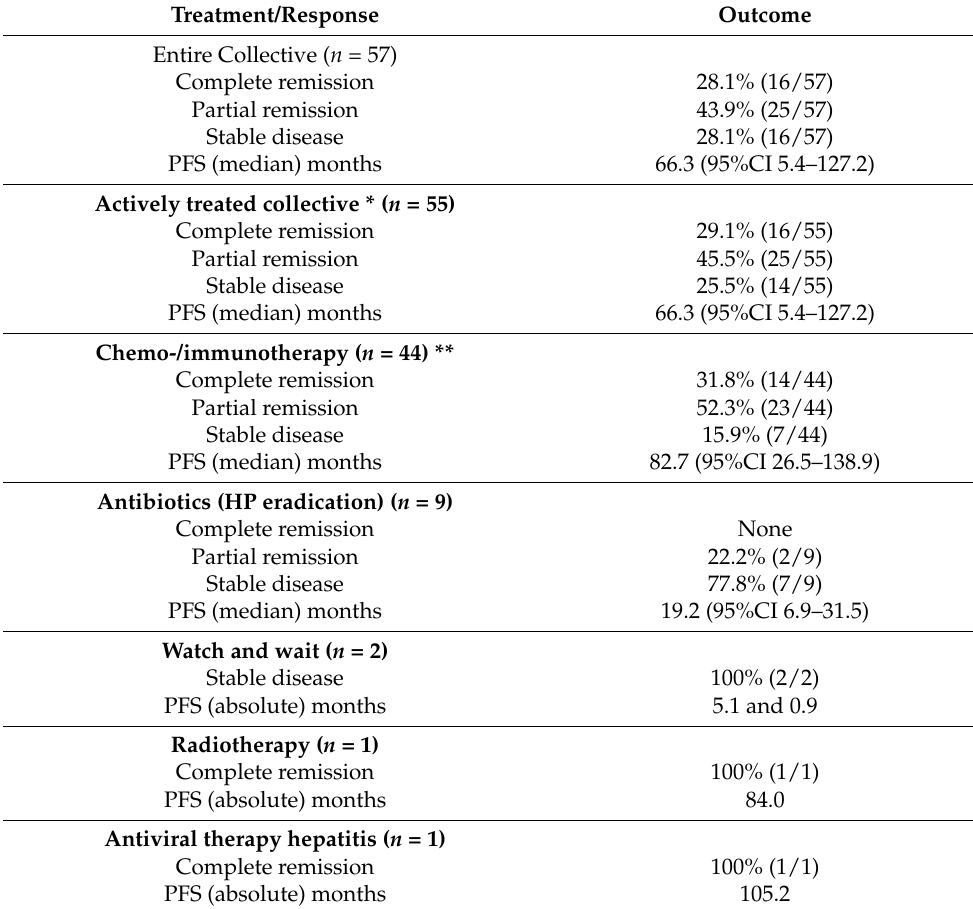
Table 2. First line treatment and outcome of 57 patients with H. pylori negative MALT lymphoma.